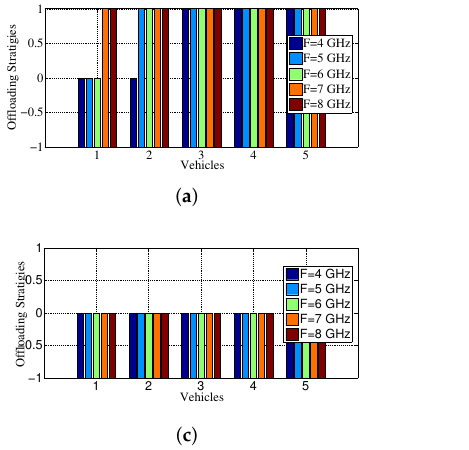
Figure 3. The impacts of the capacity of the VEC server on the offloading strategies. ( a ) γ i , t = 0.2, γ i , e = 0.8; ( b ) γ i , t = 0.5, γ i , e = 0.5; ( c ) λ i , t = 0.8, γ i , e =